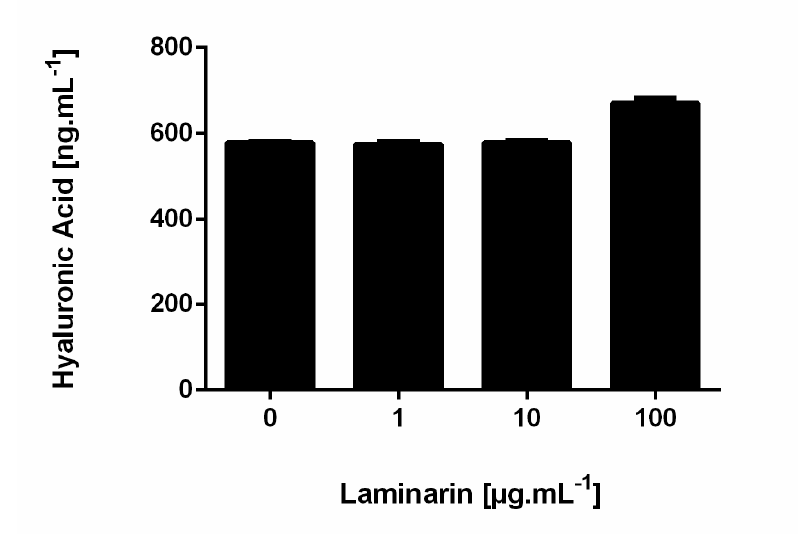
Figure A3. Quantitative analysis of hyaluronic acid (HA) by ELISA assay. HaCaT cells were treated with 1, 10 and 100 µg.mL − 1 laminarin for 72 h. An ELISA assay was performed to quantified HA on cell culture medium supernatant. Data are expressed as mean ± SD of three independent experiments.